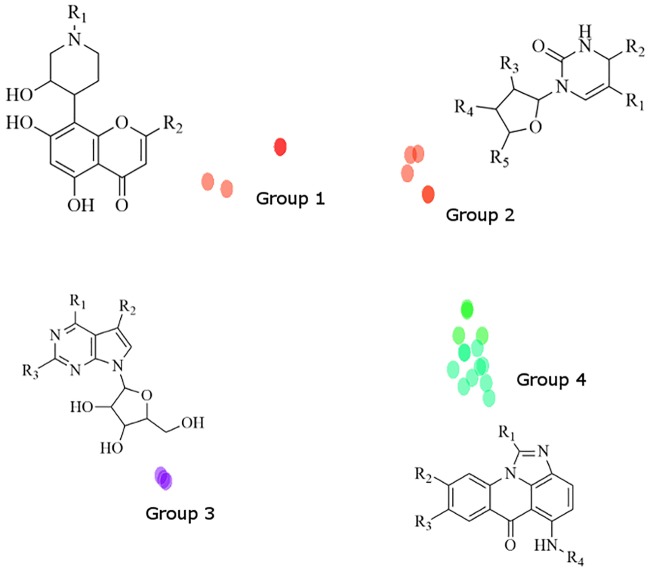
Chemical similarity mapping of hits identified through molecular docking.The composite method identified 25 compounds that could be grouped into four different scaffolds. Group 4 contained the highest number of compounds with 13 identified putative inhibitors. A complete list of compounds can be found in the Supplementary Information (S1 Table).